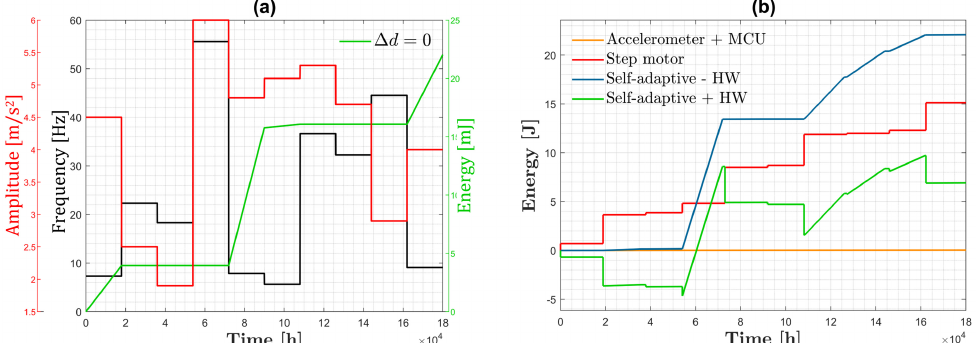
Figure 10. ( a ) Ten random frequency and amplitude patterns under PTC on the left y-axis and correspondent harvested energy on the right y-axis for non-adaptive harvester; ( b ) energy demand from sensing, processing and actuation systems—self-adaptive harvested energy neglecting the hardware consumption, as well as considering the hardware consumption. The accelerometer inactivation time was set to 45